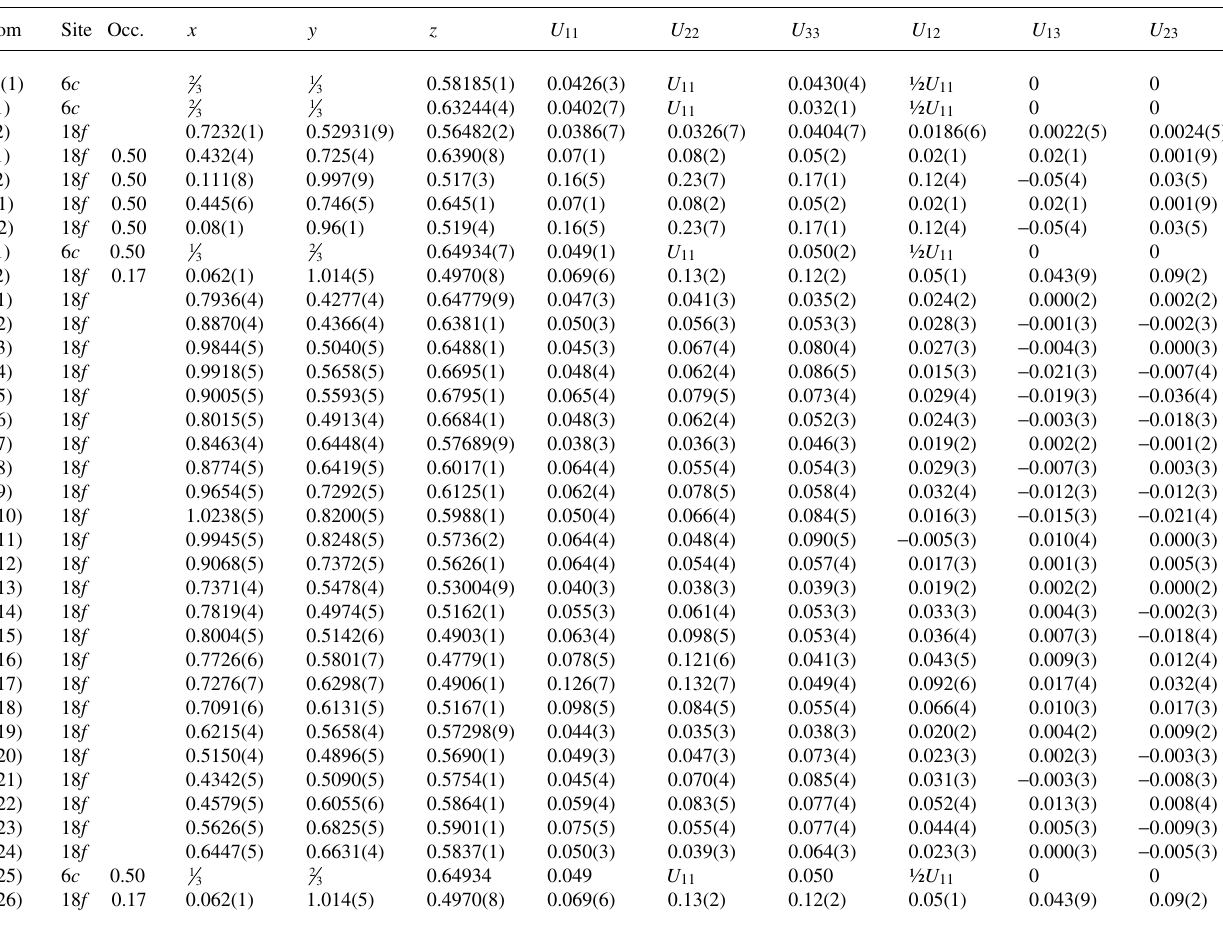
Table 3. Atomic coordinates and displacement parameters (in Å 2 )